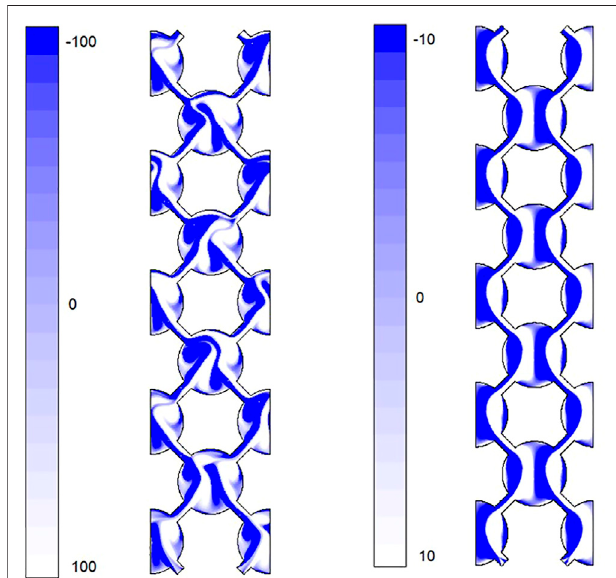
FIGURE 5 | Contour plot of the z -component of the vorticity of the 2D ExtendedNUB simulation at 34s for Re (cid:1) 300 (A) and Re (cid:1) 100 (B) .